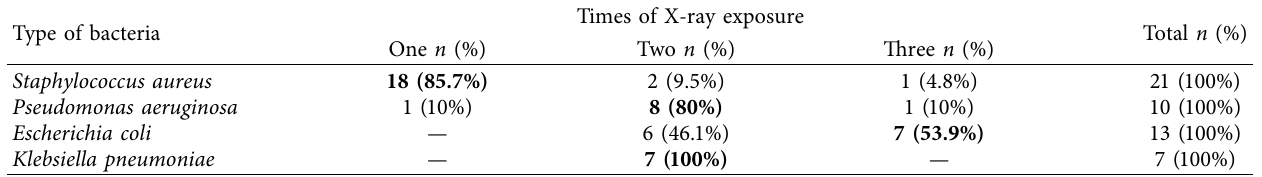
Times of X-ray exposure